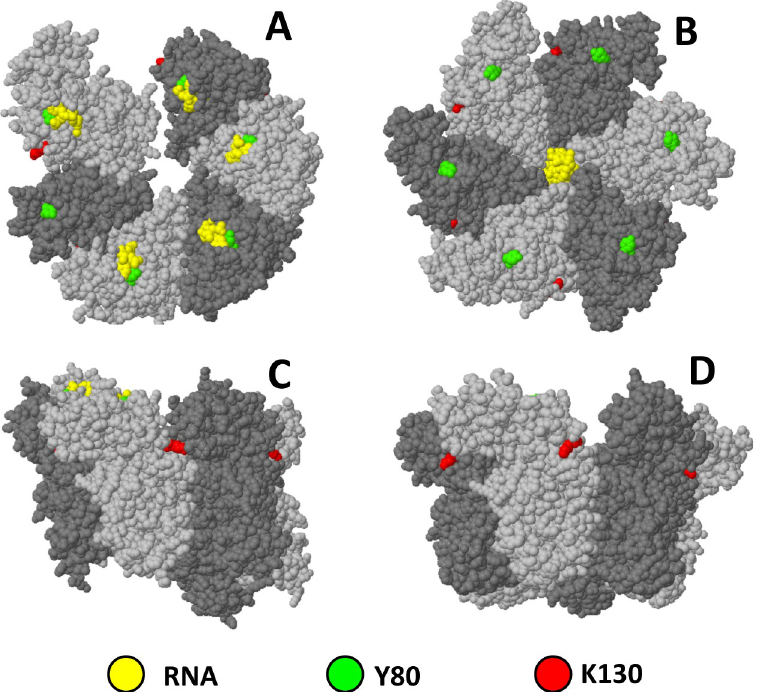
Fig 2. Spacefill representations of Rho protein 3D structures showing the positions of the amino acid residues changed in mutants Y80C and K130Q. Structures correspond the open and closed configurations of the Rho hexamer ( left and right , refs [75] and [76], respectively) visualized with Jmol (an open-source Java viewer for chemical structures in 3D. http://www.jmol.org/). (A) and (B) Top view ; (C) and (D) Side view .